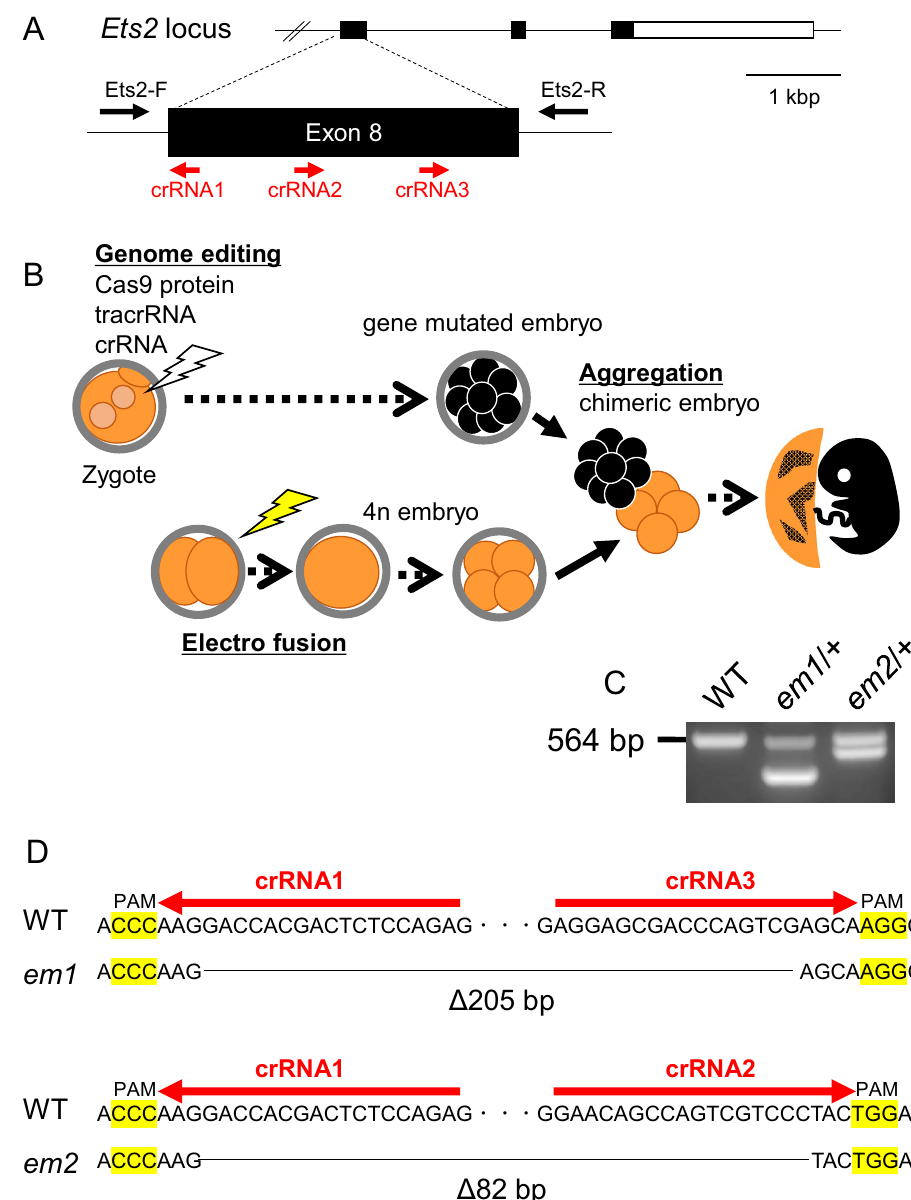
Figure 1. Generation of new Ets2 mutant models using zygotes. (A) Design of crRNA targeting sites in exon 8 of the Ets2 gene and checking primer positions. (B) Strategy for obtaining Ets2 homozygous mutant l in F0 generation using the electroporation technique and the tetraploid method. (C) Genotyping of the two newly generated Ets2 mutants in F0 generation. Both had a wildtype (WT: 564 bp) allele and a deletion allele ( em1 or em2 ), which were detected as shorter bands than WT. (D) DNA sequence of mutant alleles and crRNA targeted sequences. The 205 bp deleted (Δ205 bp) allele was named em1 , and the 82 bp deleted (Δ82 bp) allele was named em2